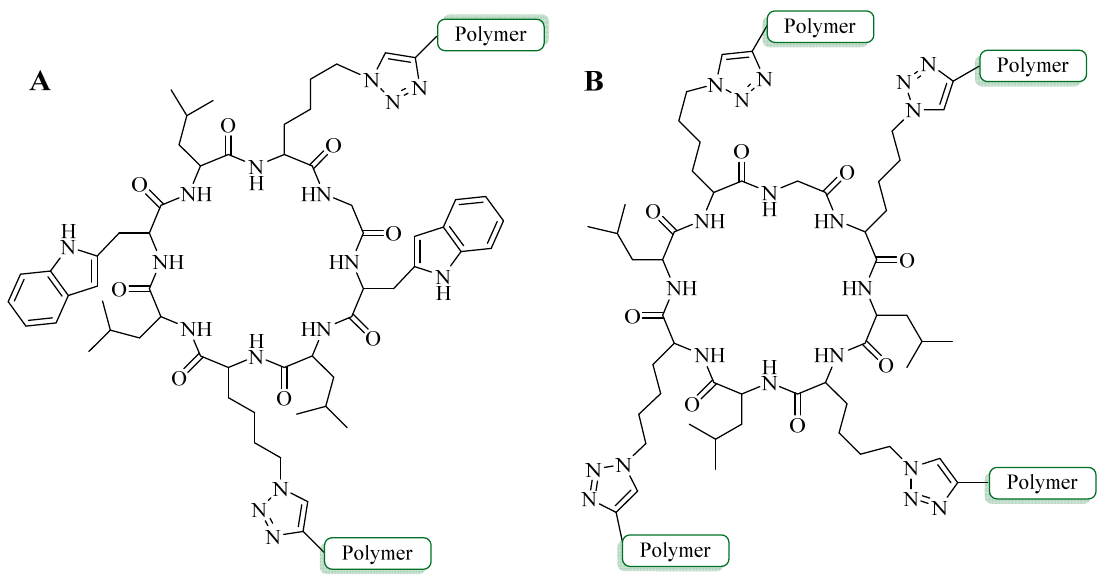
Figure 9. Cyclic peptides scaffold for CuAAC bioconjugation with PBA polymer: ( A ) two-arm cyclic peptide, ( B ) four-arm cyclic